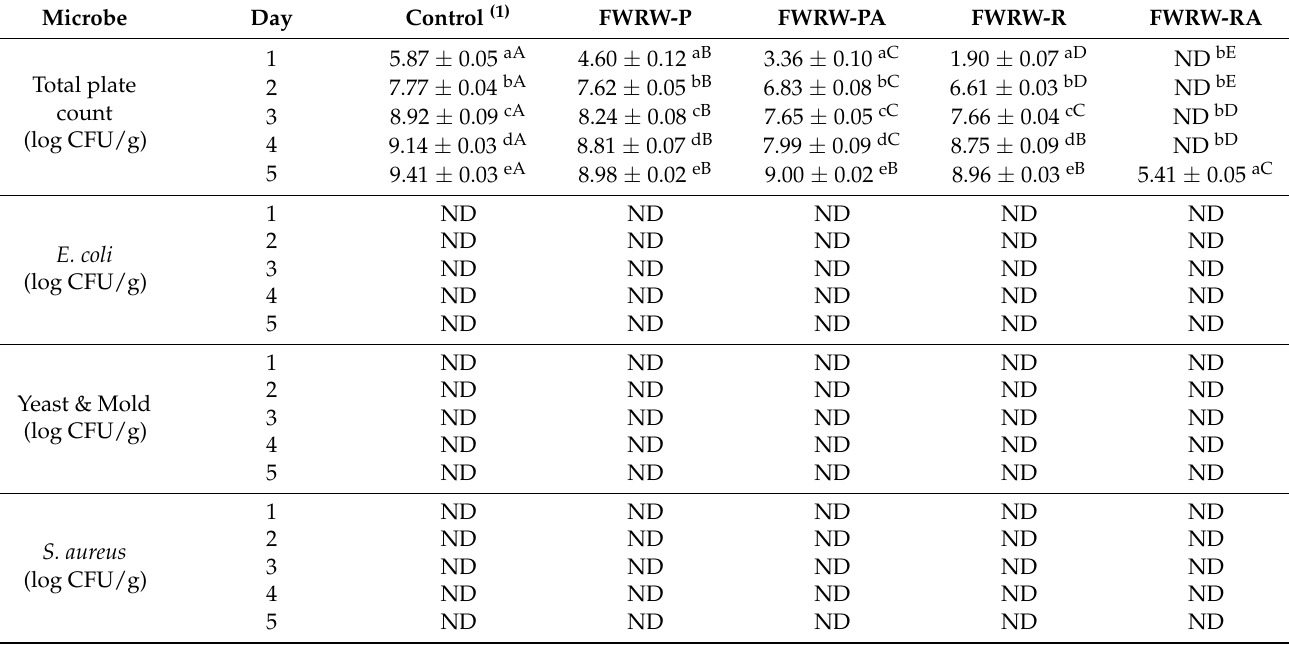
ND, not detected. (1) Garaetteok treated with water only. Data are shown as means ± standard deviations ( n = 3). Different lowercase or uppercase letters mean that each of them is significantly different in the same column or row, respectively ( p < 0.05).